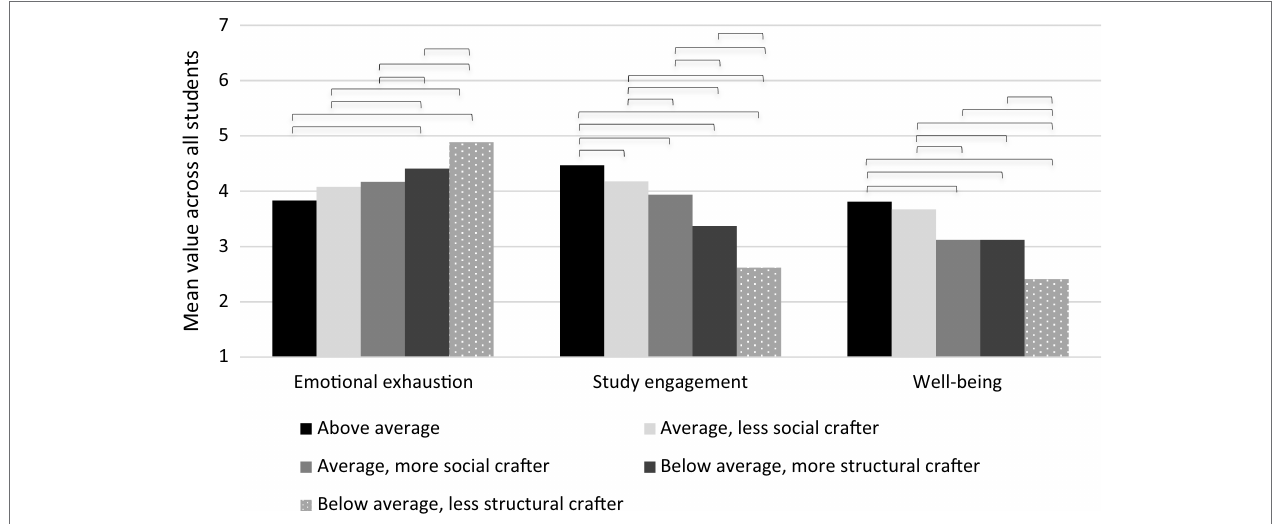
FIGURE 2 | Mean values of outcomes for each profile. N = 2,822. Emotional exhaustion with values from 1 to 7. Study engagement and well-being with values from 1 to 6. Square brackets indicate significant differences according to Wald